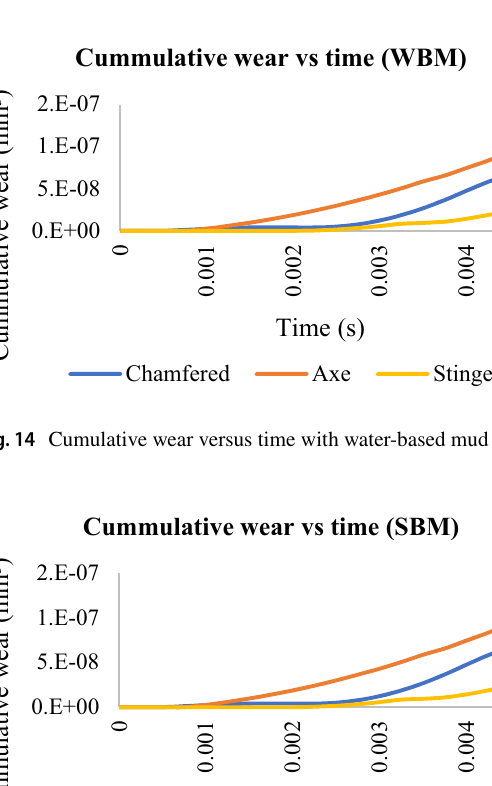
Fig. 13 Cumulative wear versus time with oil-based mud